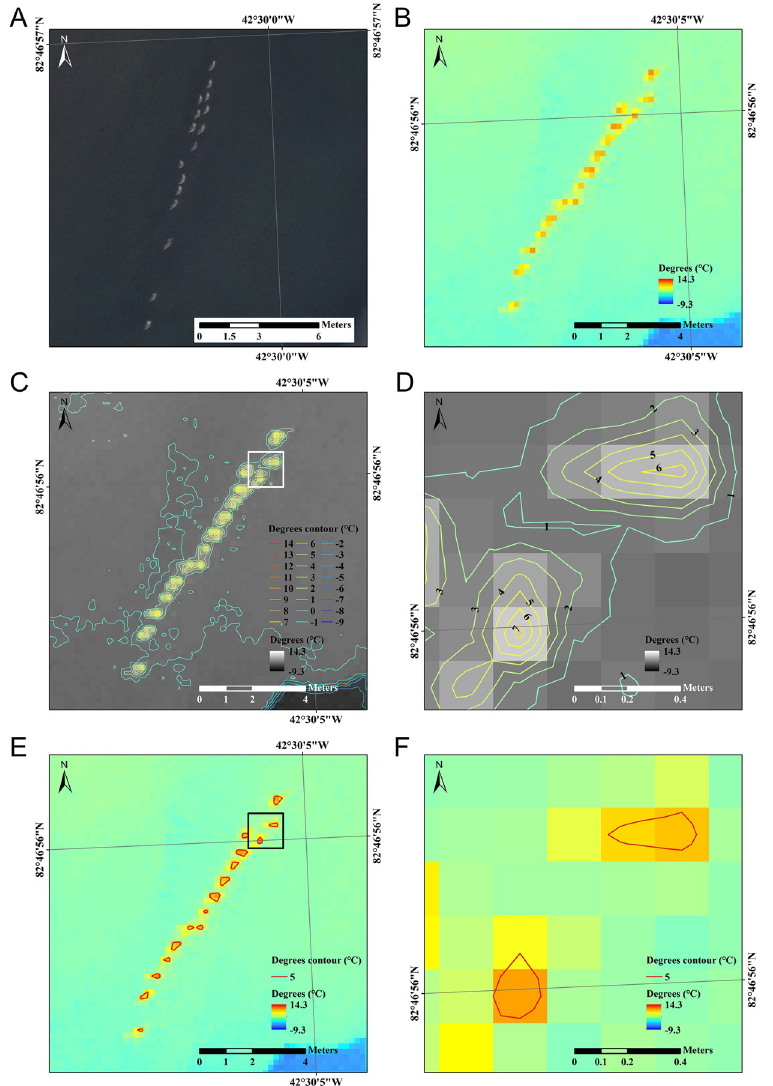
Fig 3. UAV images of pink-footed geese at the seashore. (A) Zoomed RGB mosaic image. (B) Zoomed thermal image. (C) 1˚C-interval temperature contours in the thermal image. (D) Detailed view of the temperature contours around geese pixels within the area of the white box in (C). (E) Contours using a 5˚C temperature threshold for a flock of sixteen geese. (F) Detailed view of the temperature contours with 5˚C temperature threshold of the black box in (E) that provided the conservative proximate size of the geese (35 ( ± 2.5, SE) cm long). In the case of -1˚C adjusted contour polygons (i.e., 4˚C contour polygons), two pairs of geese polygons were merged into one polygon, and these merged polygons were not considered in the calculation of the size of the geese. In the case of +1˚C adjusted contour polygons (i.e., 6˚C contour polygons), one polygon was removed, as the selected 5˚C was the highest temperature depicting an individual goose.